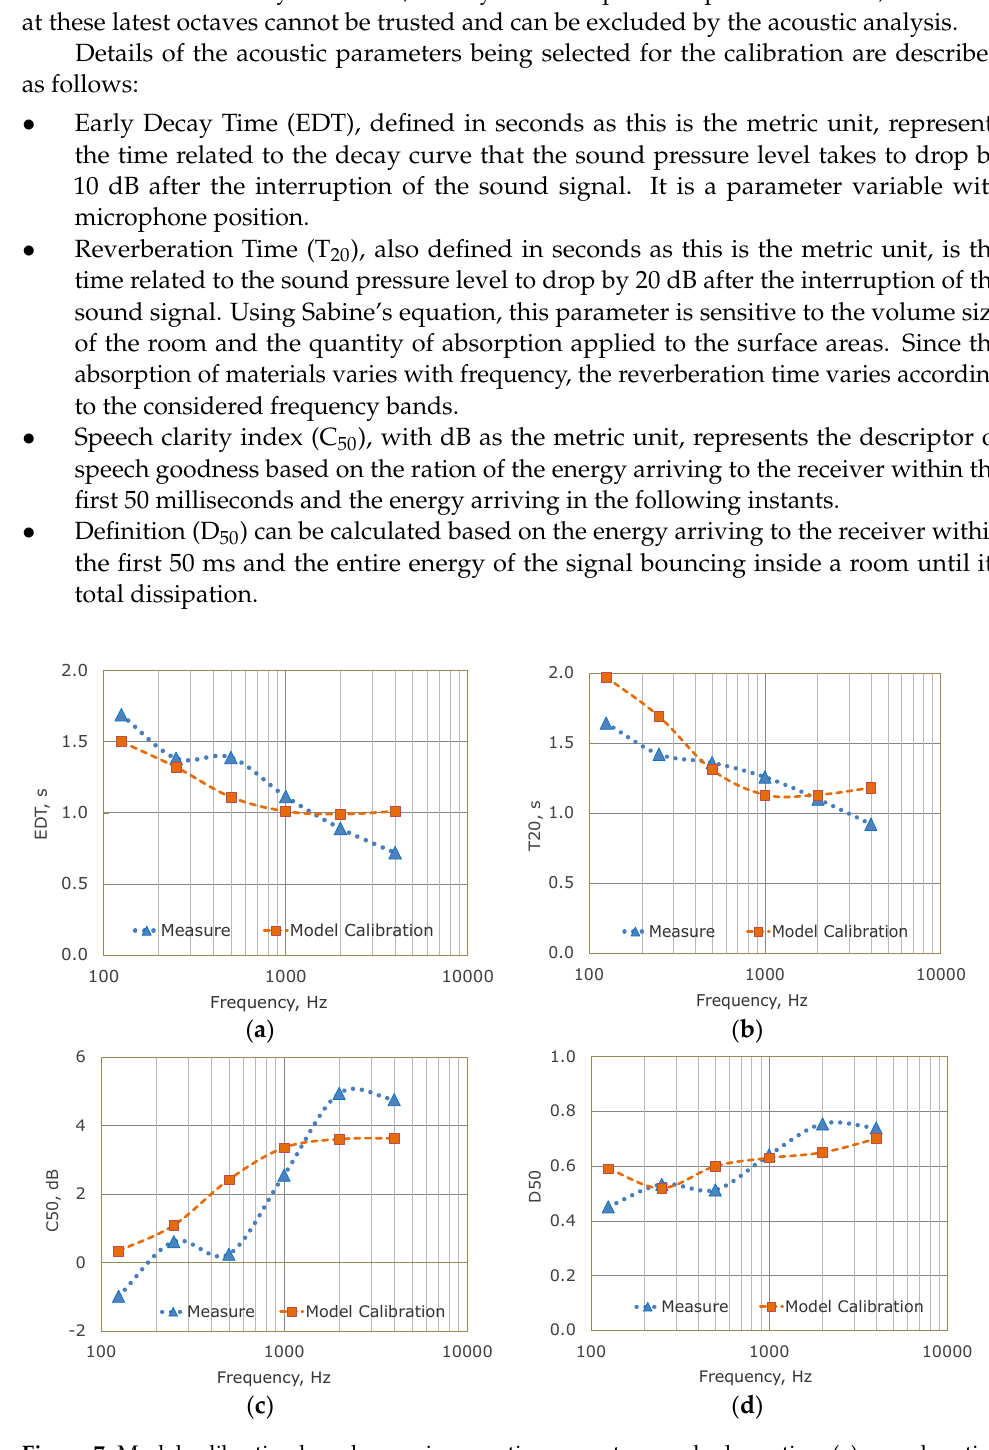
Figure 7. Model calibration based on main acoustic parameters: early decay time ( a ), reverberation time ( b ), clarity index ( c ), and definition ( d ).